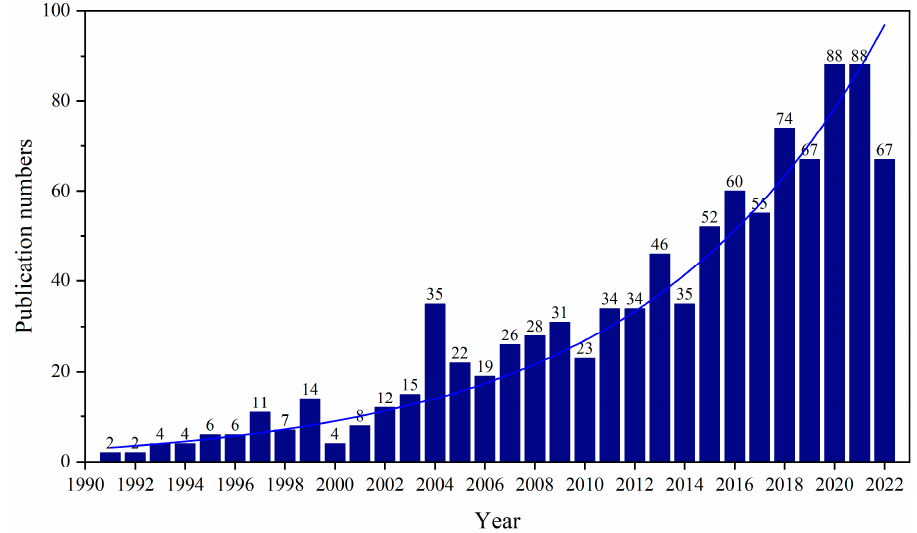
Figure 1. Temporal distribution of published articles on tannery wastewater from 1991 to 2022. Out of the 979 papers published between 1991 and 2022, the number of publications each year on tannery wastewater is shown. The research into tannery wastewater began in 1991, and the number of publications has steadily increased over time. Research on tannery wastewater has been divided into three distinct periods: an “embryonic” phase (1991–2003), a “maturity” period (2004–2012) and an “explosive growth” period (2013–2022). The amount of attention paid to tannery wastewater varies over time, and the number of articles published each year on a particular topic might indicate how far research in that field has progressed.